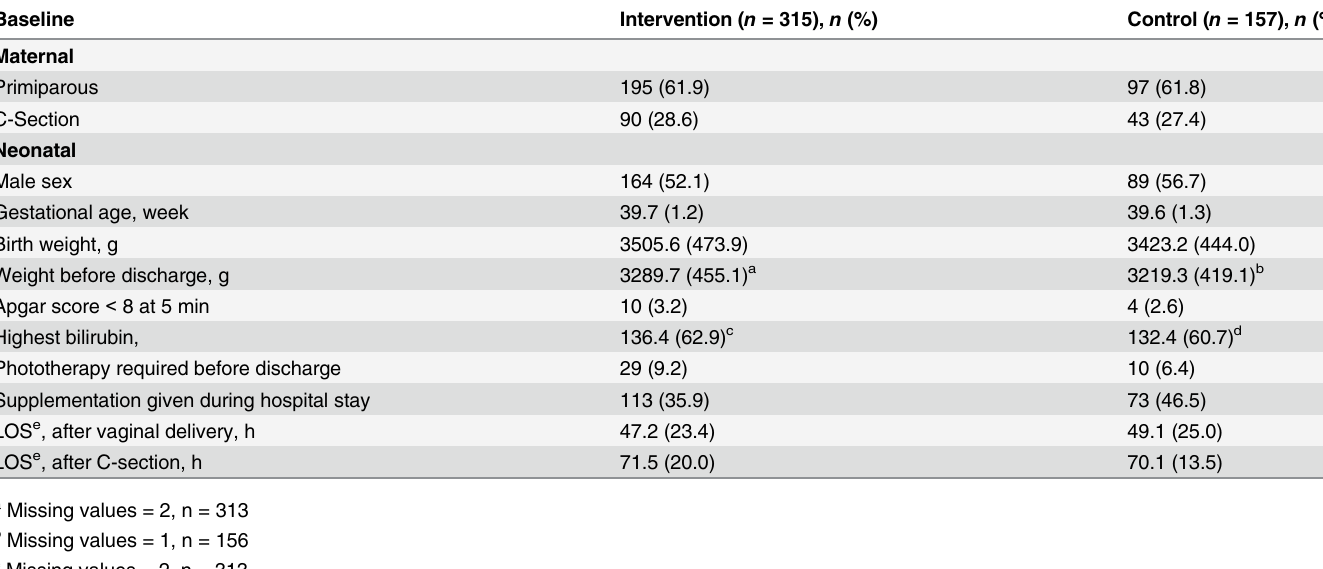
Table 2. Baseline Characteristics.